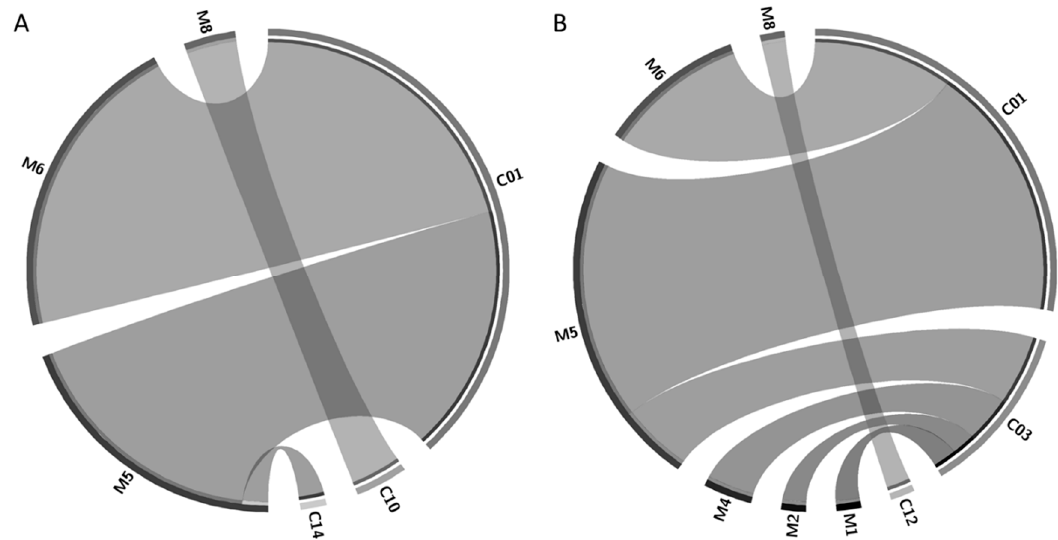
Figure 1. Circos graphic representations of symbiotic combinations of mycobiont (M) and cyanobiont (C) haplotypes in Site 1 ( A ) and Site 2 ( B ). The width of the ribbons represents the relative abundance of the symbiotic combinations that are connected. For reference, C14 and C12 have an abundance of one in Site 1 and Site 2, respectively.